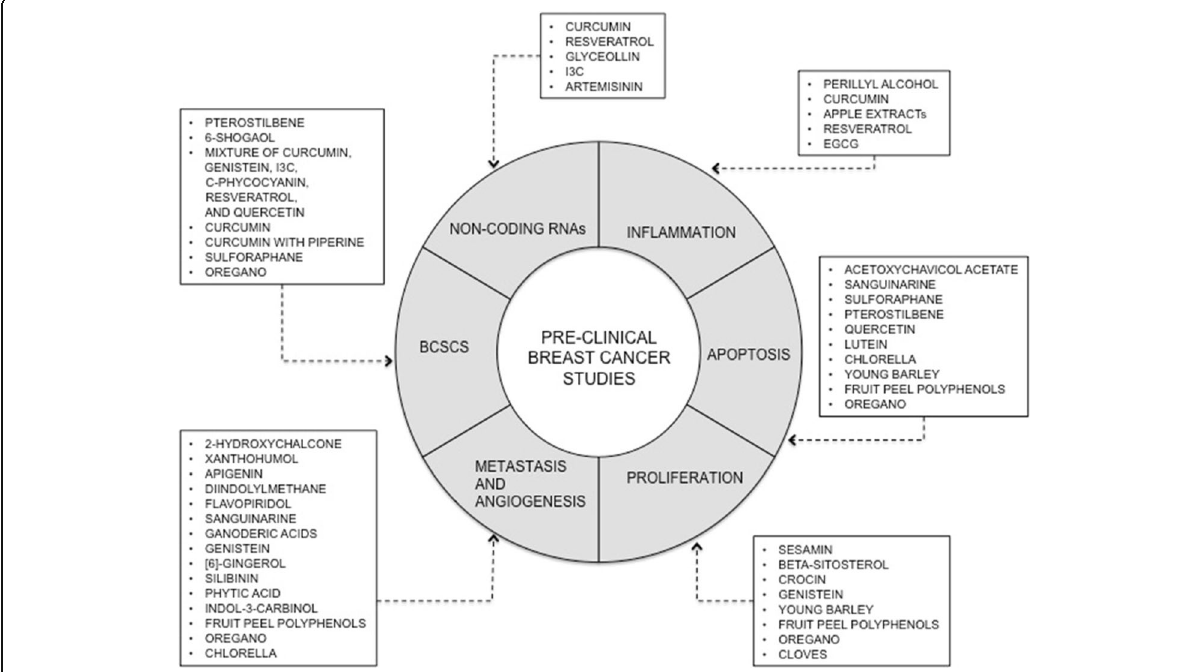
Fig. 1 Bioactive plant-derived substances and their mechanism of action in the process of mammary